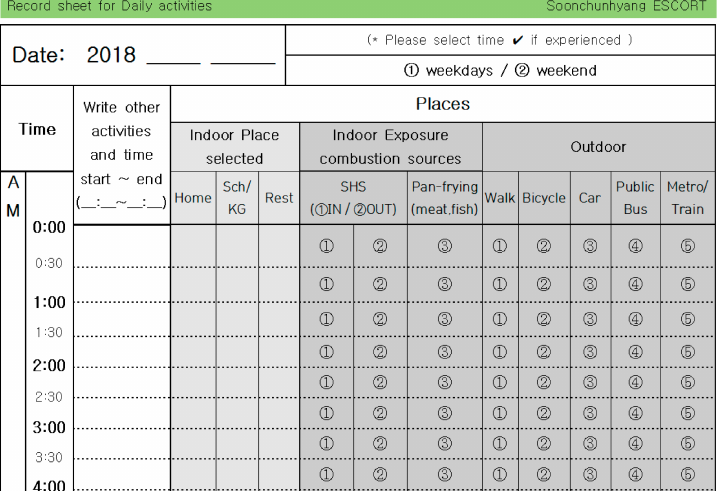
Figure 1. An example of the daily activity diary used to collect information of study participant’s activity pattern. (Sch: School, KG: Kinder garden, SHS: Secondhand